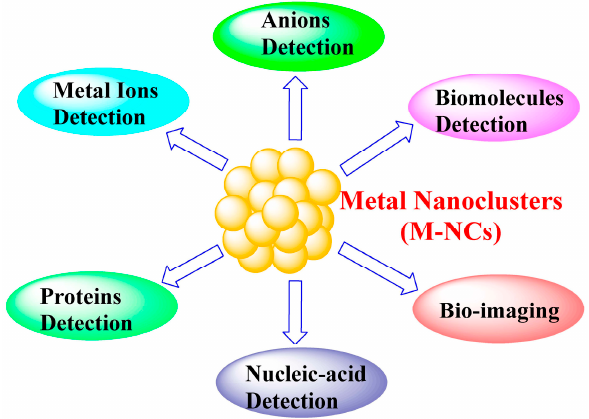
Figure 1. Schematic representation of chemosensor applications of metal nanoclusters (M-NCs).